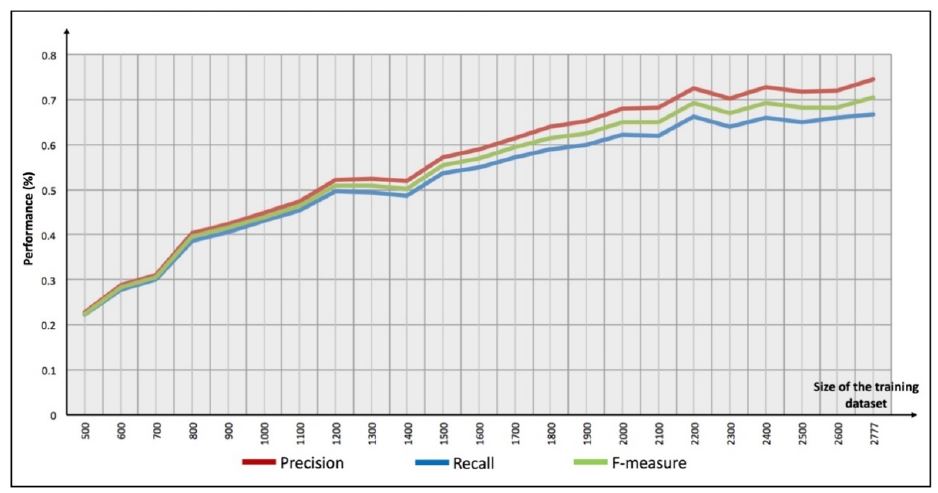
Figure 10. Relationship between the size of the training dataset and the precision, recall, and F ‐